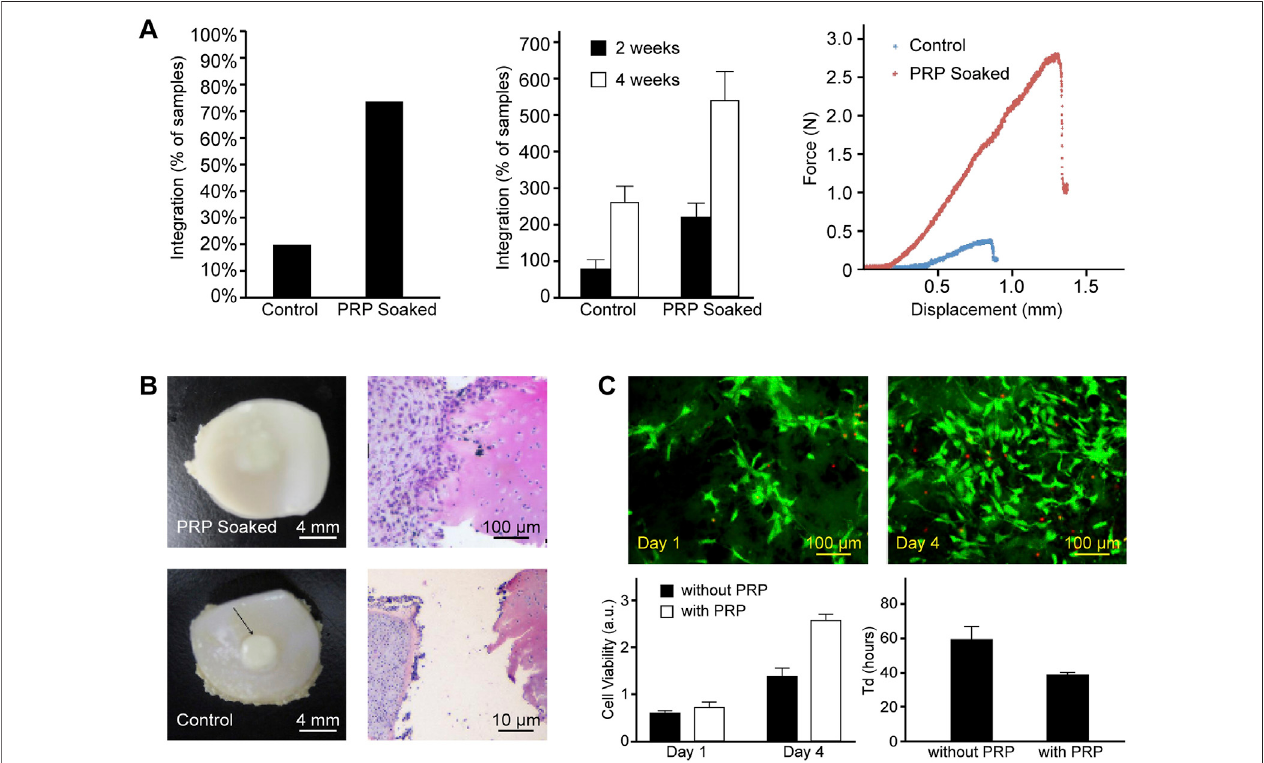
FIGURE2 | Encapsulation of PRP enhances integrationof implants with native tissueand MSC proliferation on scaffolds. (A) PRP-soaked bioengineered implants showed a higher percentage and greater strength of integration. (B) Gross and histological appearance of PRP-soaked and untreated implant – explant constructs. Reproduced with permission from Sermer et al. (2018). (C) Fluorescence images by LIVE/DEAD staining. Statistical results showed enhanced cell viability and a shortened doubling time of MSCs in the parylene-based scaffold when compared to the sample group without PRP. Reproduced with permission from Wu et al.